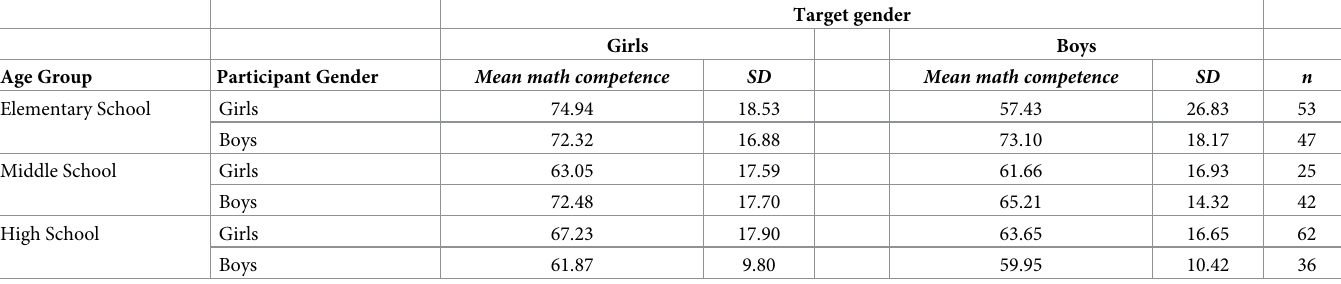
Table 4. Math explicit belief scores by participant gender, age group, and target gender.